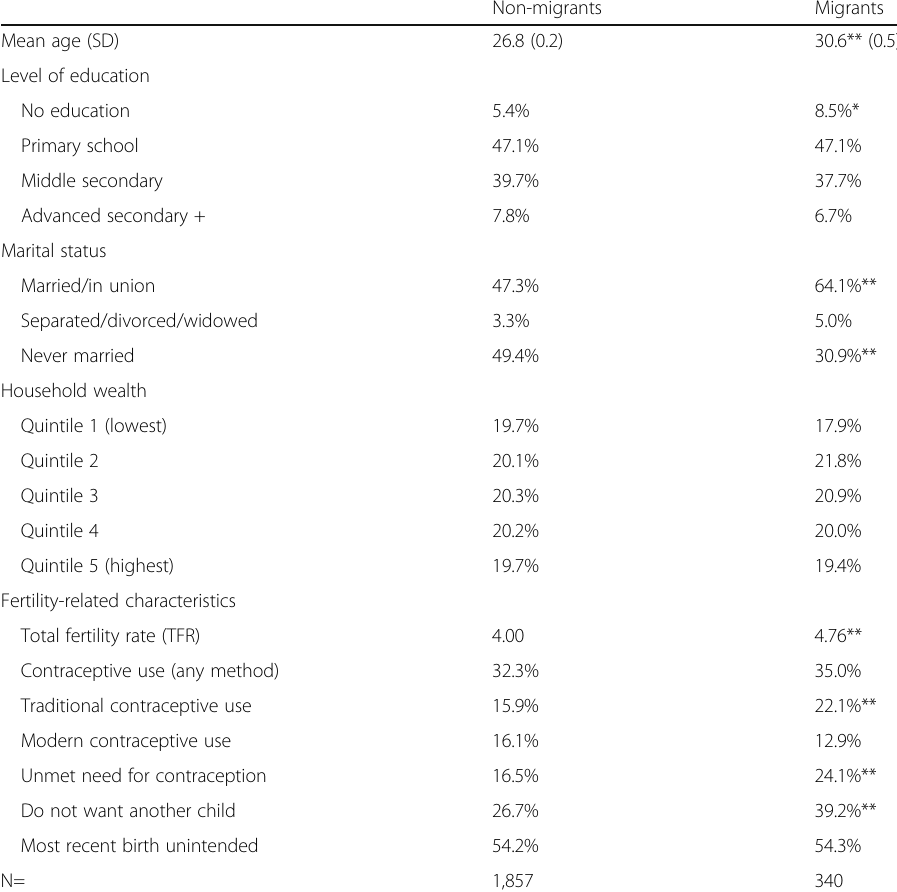
Table 1 Background characteristics for migrant and non-migrant women, PMA2020 Project, Kinshasa 2013